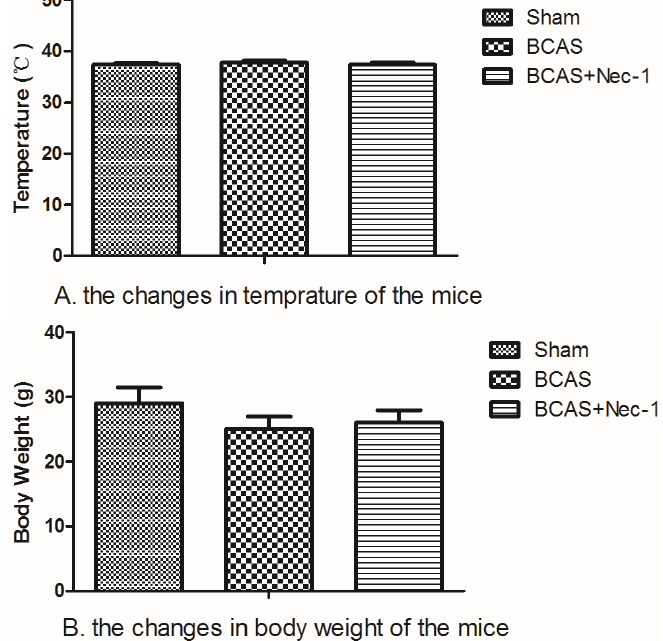
Figure 2. The changes in temperature and body weight of the mice. ( A ) The changes in temperature of the mice were assayed. At the 15th day, temperature of the mice had no statistical difference in three groups ( P > 0.05); ( B ) The changes in body weight of the mice were assayed. At the 15th day, temperature of the mice had no statistical difference in three groups ( P > 0.05), although the body weight of the mice has a downward trend in the BCAS and BCAS with Nec ‐ 1 groups.